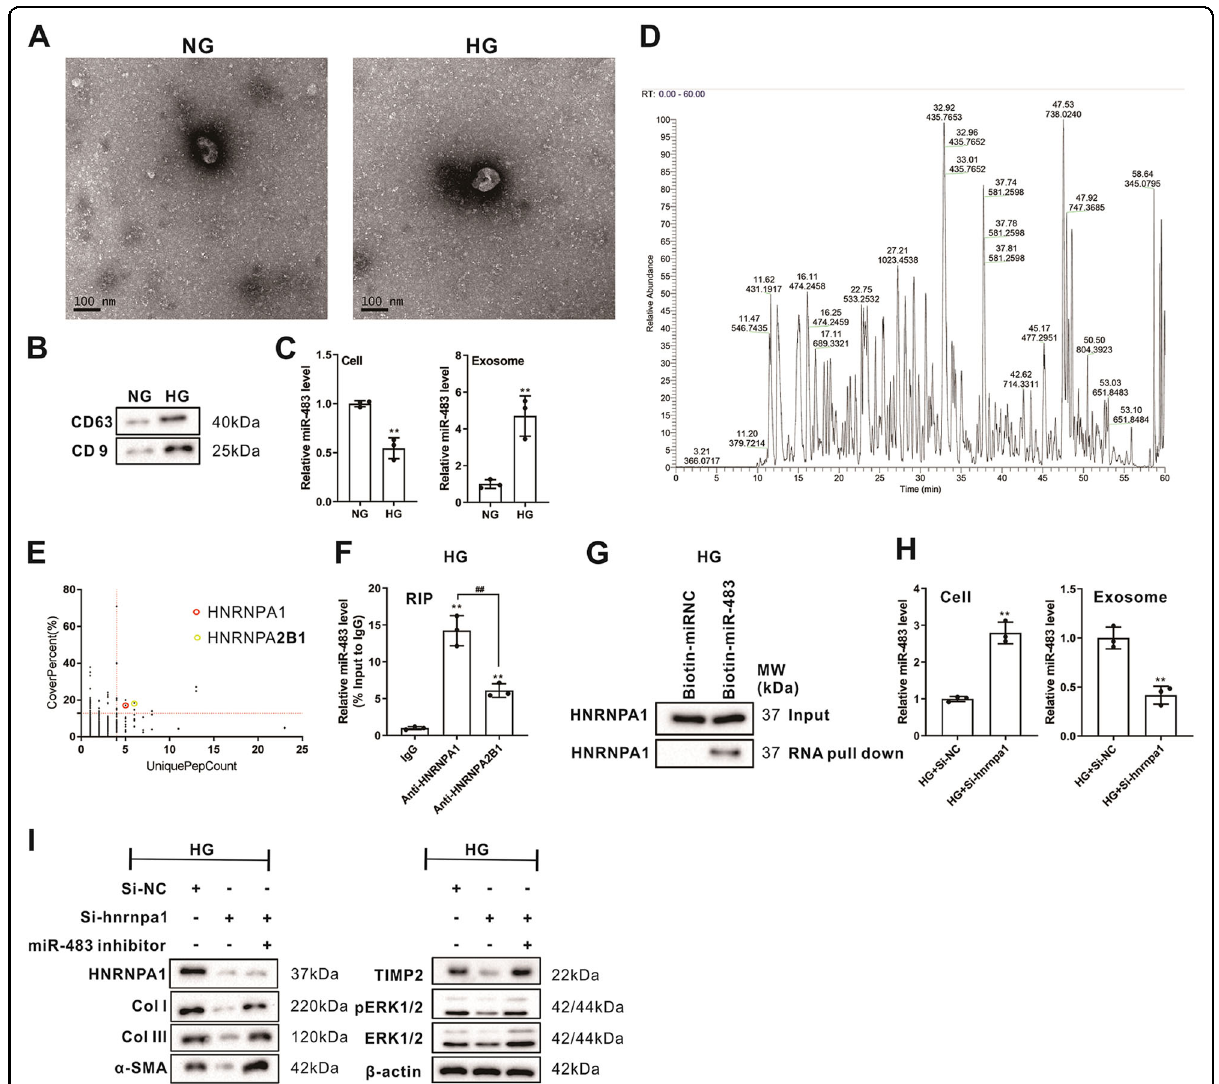
Fig. 7 Effect of the transport protein HNRNPA1 on the exosomal sorting of miR-483-5p in renal TECs. A The primary mouse renal TECs were cultured under NG and HG conditions for 48 h, and their exosomes were isolated for veri fi cation by TEM (Scale Bar = 100 nm) and B western blot (CD63 and CD9 proteins). C Detection of the miR-483-5p levels in cells and exosomes by qRT-PCR. D After HG treatment for 48 h, the RNA pull-down of miR-483-5p was carried out, and the eluate was subjected to mass spectrometry. E Gene Ontology (GO) analysis. F RNA immunoprecipitation veri fi cation of HNRNPA1 and HNRNPA2/B1 that bound to miR-483-5p. G RNA pull-down experiment corroborated the binding of HNRNPA1 to miR- 483-5p. H After transfecting si-hnrnpa1 into primary mouse renal TECs, the cells were treated with 30 mM HG for 48 h. Detection of the miR-483-5p levels in cells and exosomes by qRT-PCR. I After transfecting si-hnrnpa1 and/or miR-483-5p inhibitor into primary mouse renal TECs, the cells were treated with 30 mM HG for 48 h. Detection of HNRNPA1, CoL I, CoL III, TIMP2, ERK1/2, and pERK1/2 protein levels by western blot. ** P < 0.01 vs. NG, IgG or HG + si-NC. ## P < 0.01 vs. Anti-HNRNPA1. Student ’ s t -test and one-way ANOVA followed by Tukey ’ s post-test. of three independent experiments. NG normal glucose, HG high glucose, NC negative